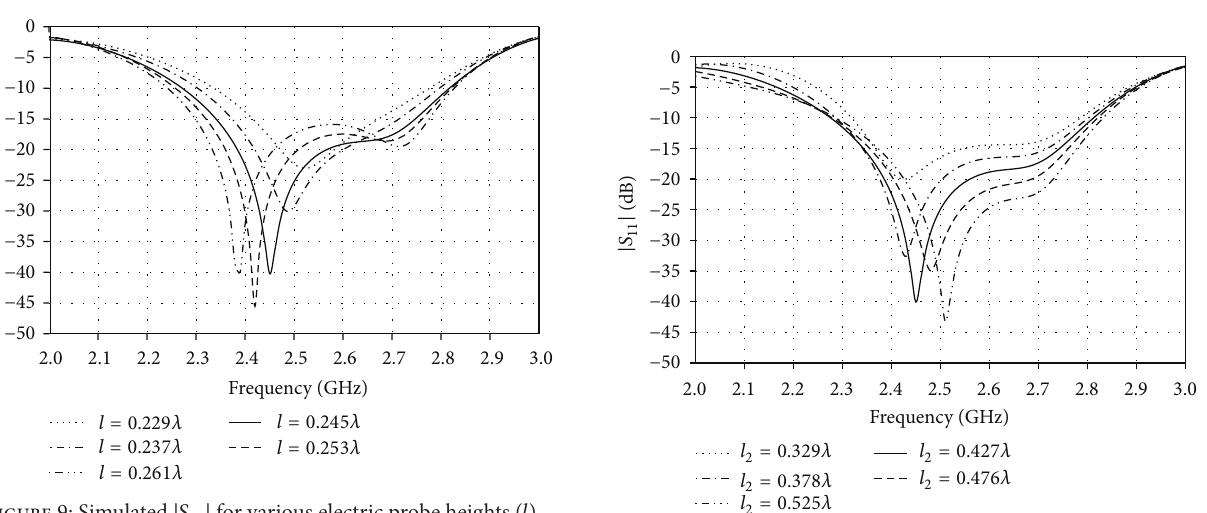
Figure 11: Simulated |𝑆 11 | for various heights of the parasitic coupling apertures ( 𝑏 1 ).